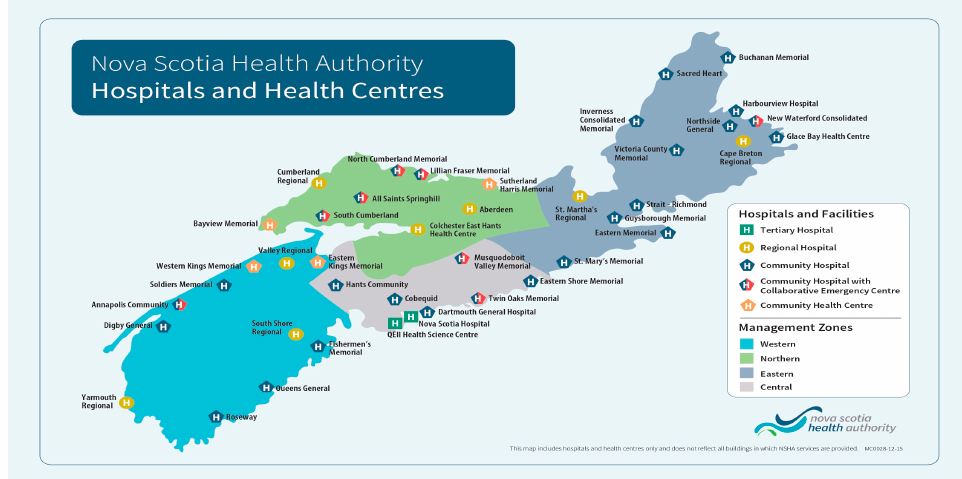
Figure 10. Hospitals and health centers for Nova Scotia Authority [83].